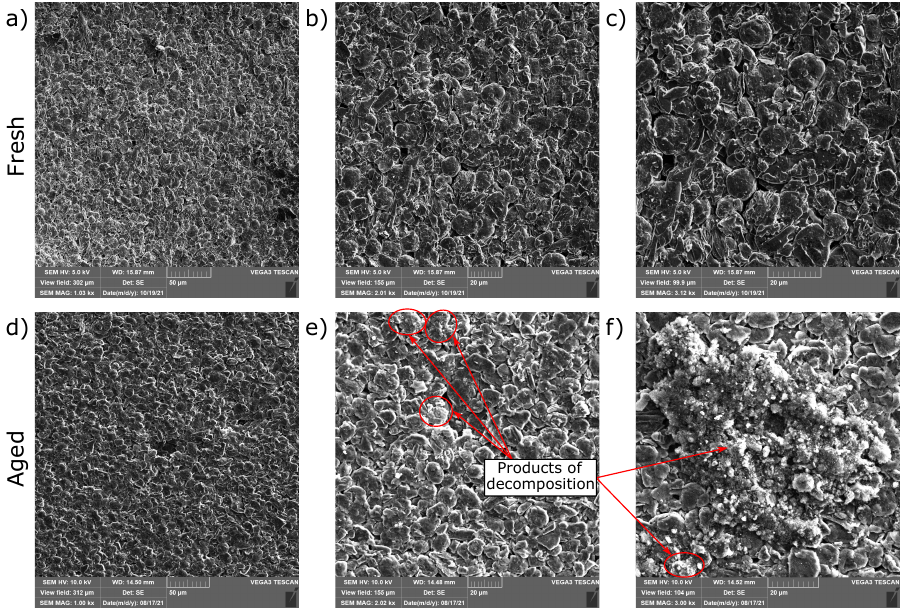
Figure 8. SEM analysis of the fresh ( a – c ) and aged ( d – f ) anode surface at different